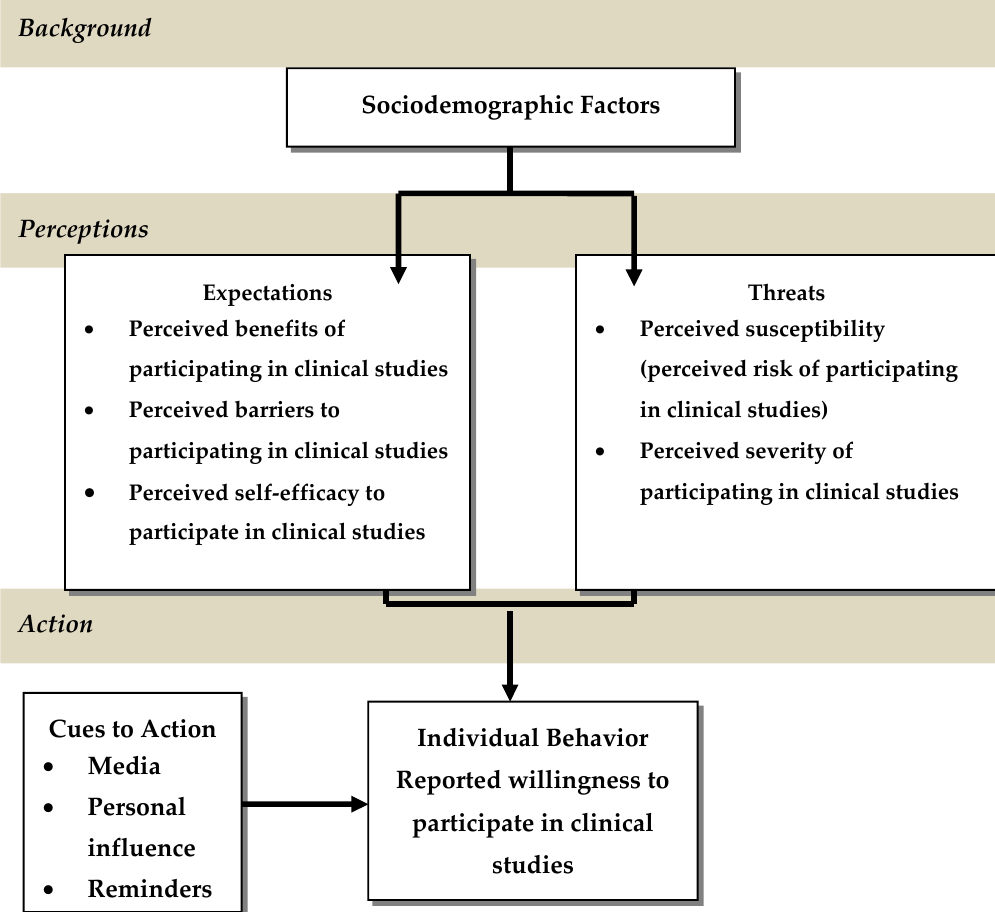
Figure 1. Health Belief Model.